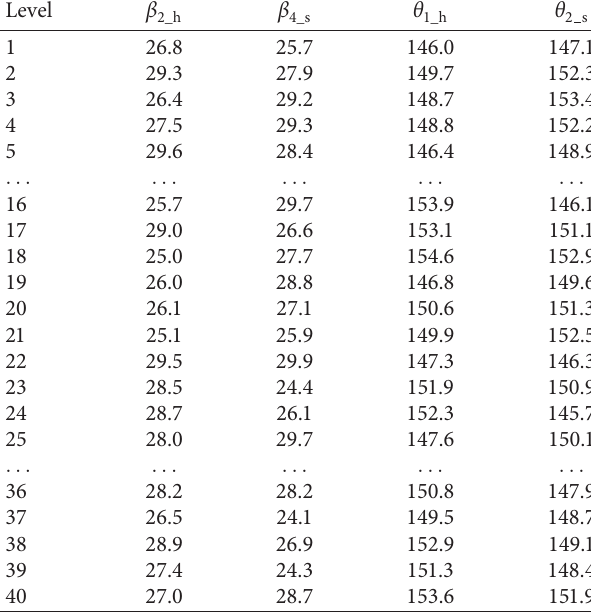
Table 8: Cases designed by LHS.